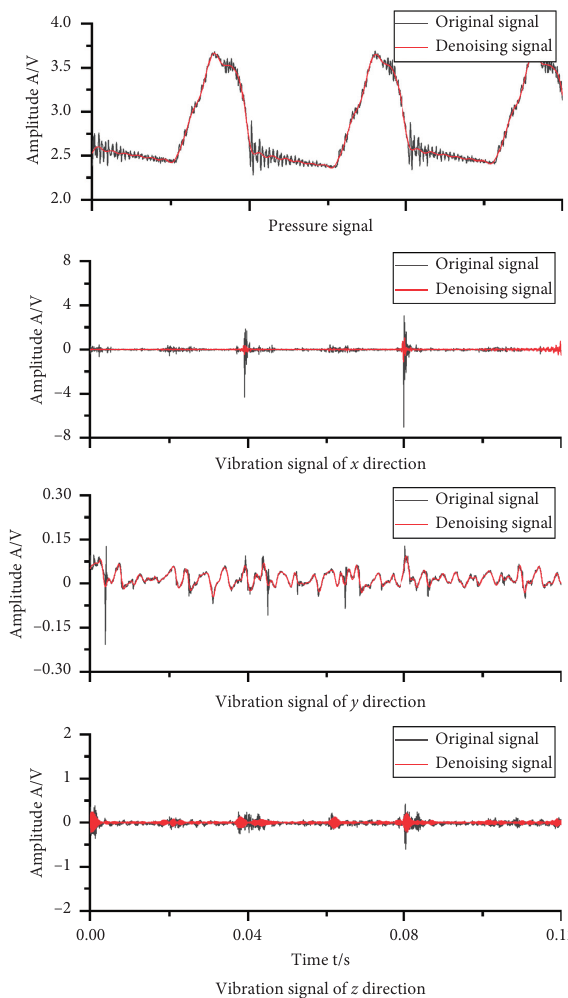
Figure 11: Original signal denoising based on